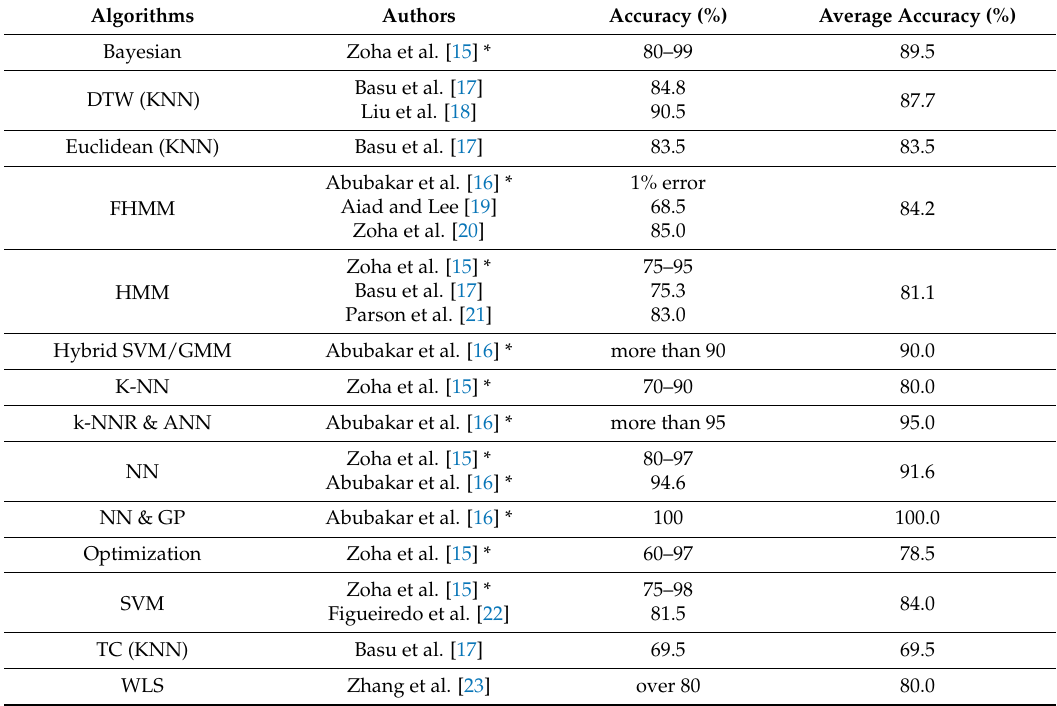
Table 1. Comparison of accuracy among algorithms applied to Nonintrusive Load Monitoring (NILM) (* refers to survey and review